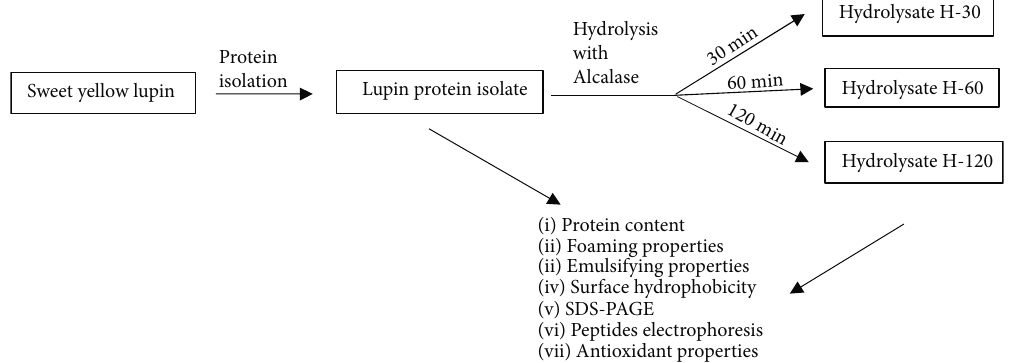
Figure 1: Flowchart presenting the experimental